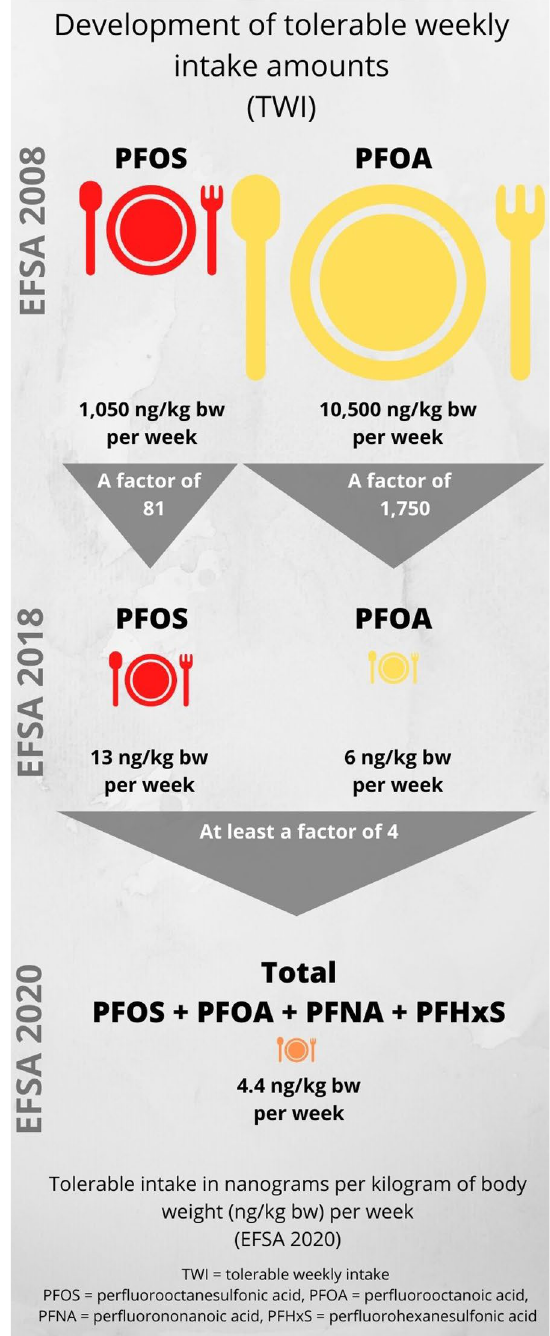
Fig. 3 Development of tolerable weekly intake amounts (TWI)